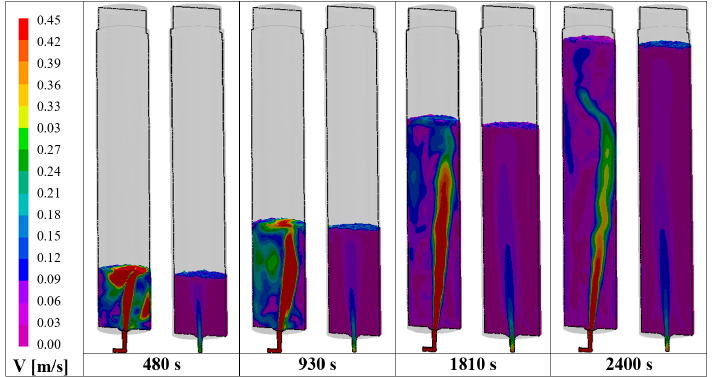
Figure 7. Filling sequence in terms of velocity distribution for both the: complete model ( left ); and simplified model ( right ).